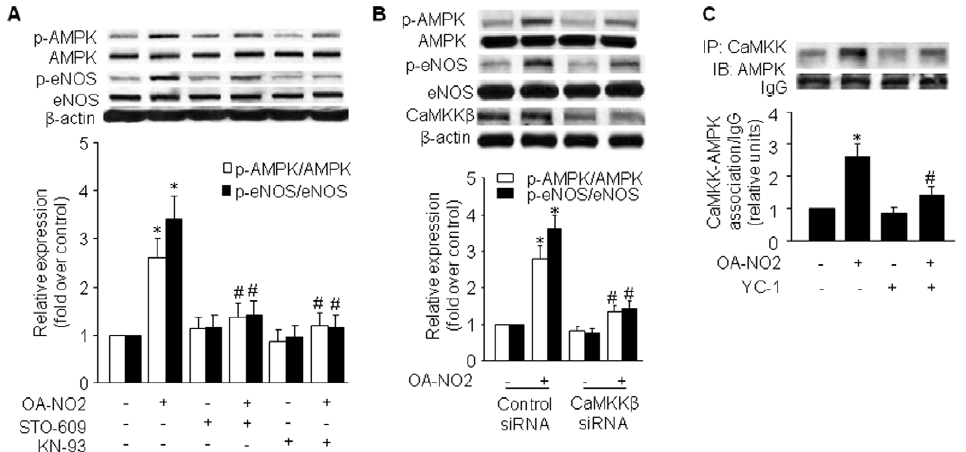
Figure 6. CaMKK is the upstream AMPKK that mediates OA-NO 2 -induced AMPK activation. A ) HUVECs were treated with STO-609 (1 m M) or KN-93 (3 m M) for 1 h followed by incubation with OA-NO 2 for 16 h. AMPK and eNOS phosphorylation and protein expression were assayed as described in Materials and Methods. The blot is representative of three blots obtained from three independent experiments. Lower panels : summary data (* p , 0.05 vs. control; # p , 0.05 vs. OA-NO 2 group; n =3). B ) HUVECs were incubated with CaMKK b -specific siRNA or control siRNA for 48 h and then treated with OA-NO 2 for 16 h. After treatment, cell lysates were analyzed for AMPK and eNOS phosphorylation and protein levels. Lower panels : summary data (* p , 0.05 vs. control; # p , 0.05 vs. OA-NO 2 group; n =3). C ) HUVECs were pre-treated with YC-1 (30 m M) for 30 min followed by incubation with OA-NO 2 for 16 h. An immunoblot of AMPK precipitated with an anti-CaMKK antibody is shown. The blot is representative of three blots obtained from three independent experiments. Lower panels : summary data (* p , 0.05 vs. control; # p , 0.05 vs. OA-NO 2 group; n =3).